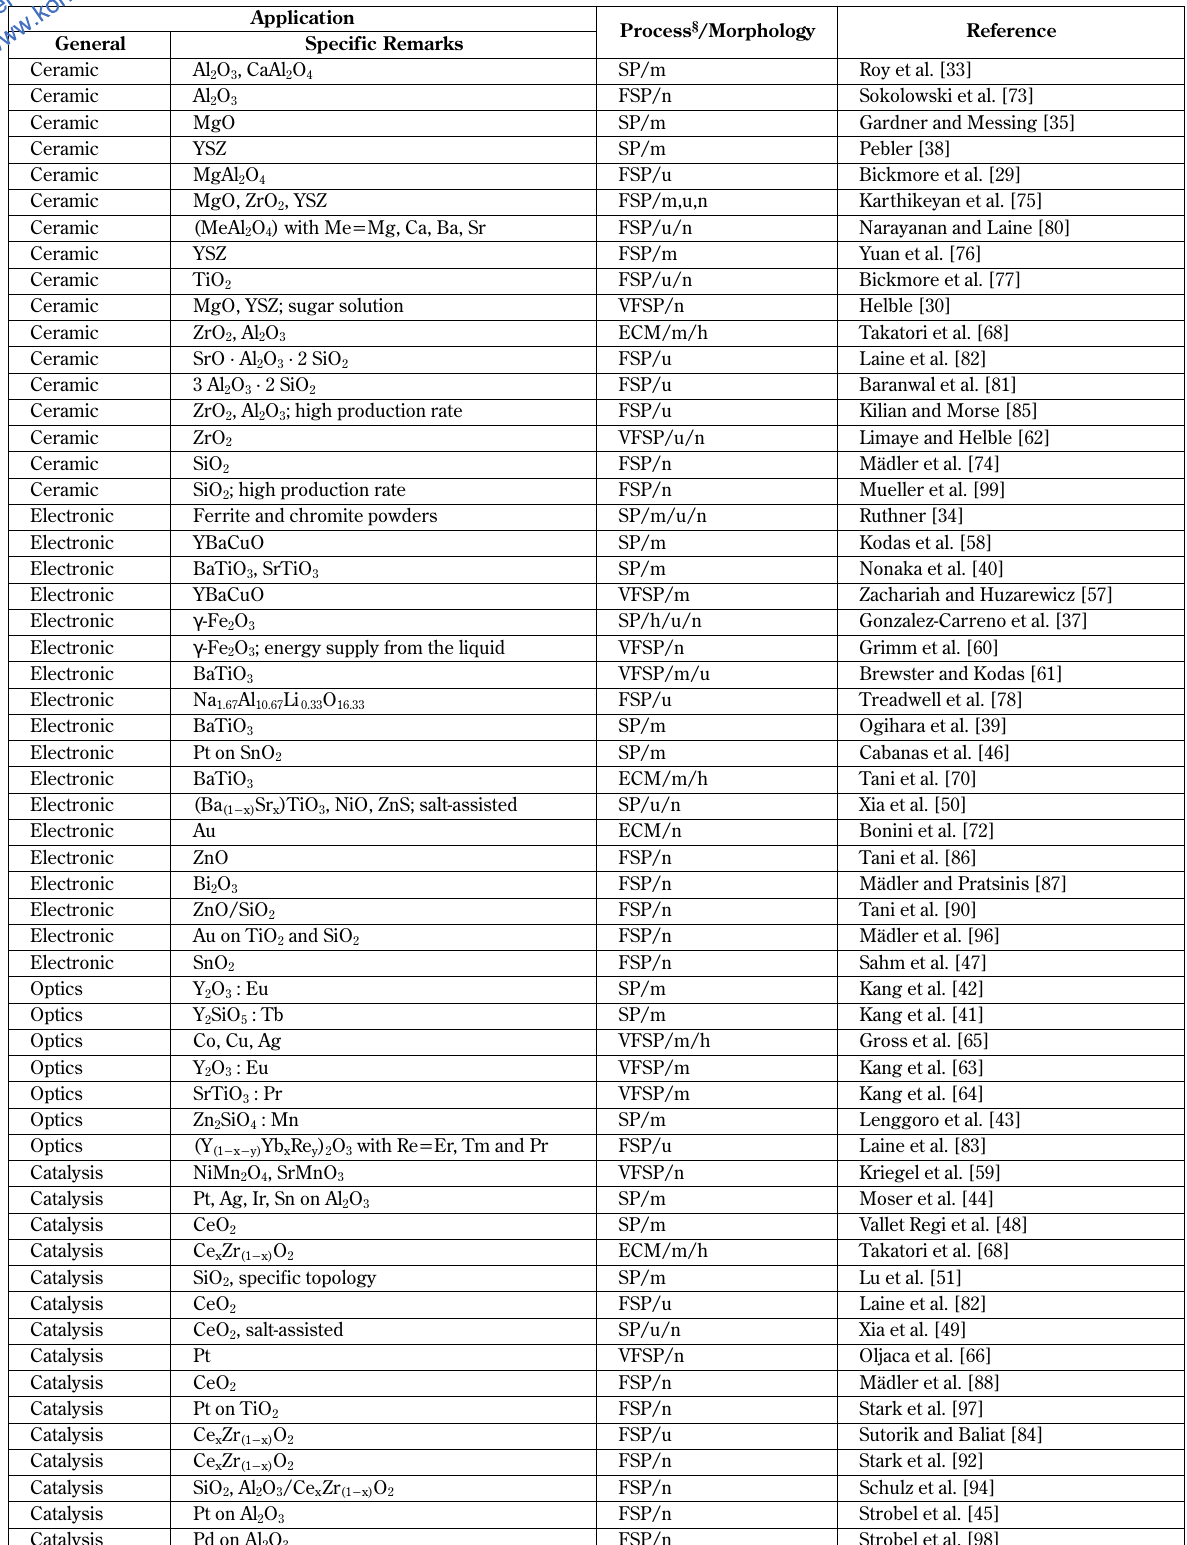
Table 1 Summary of Sections 2.1 (cid:3)